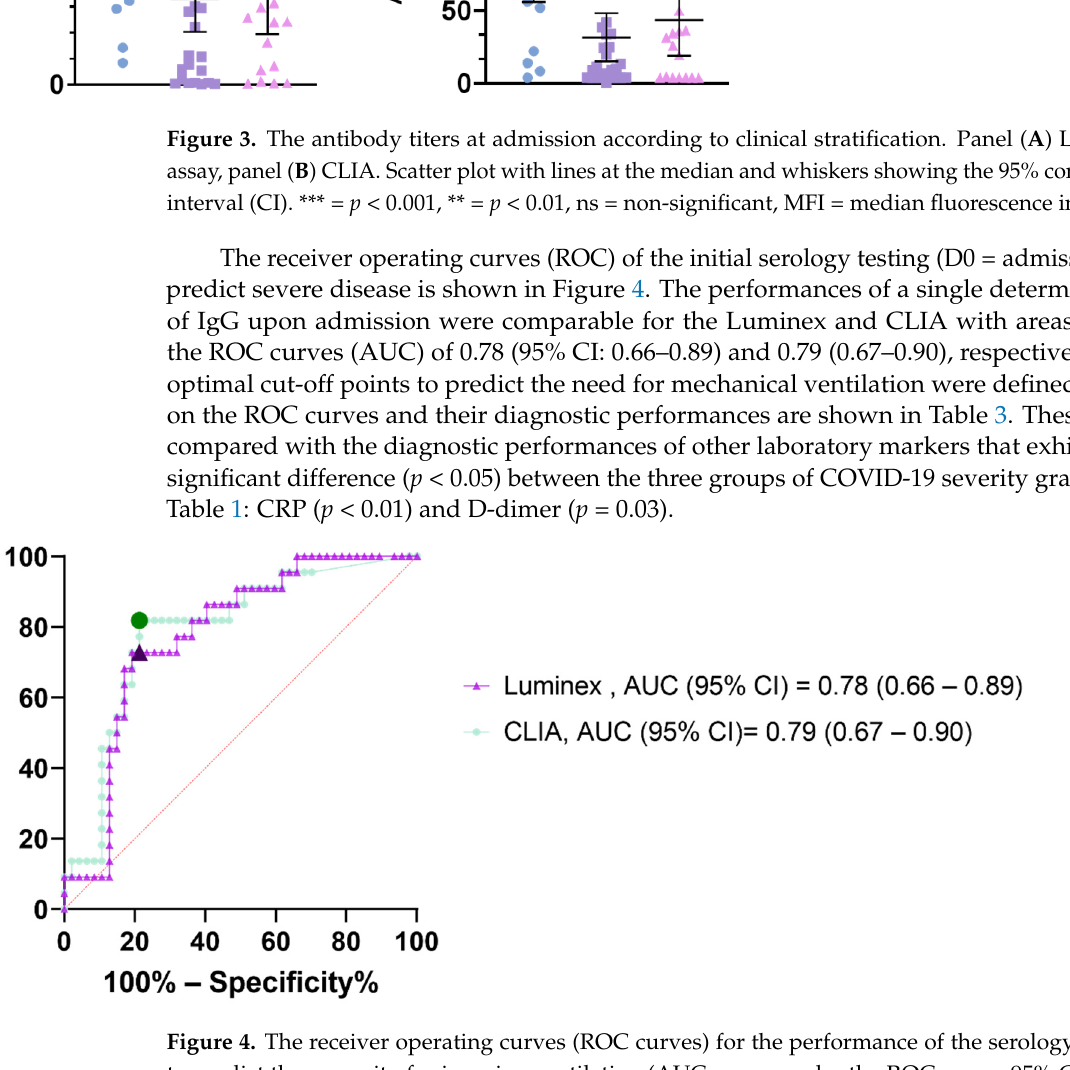
Figure 4. The receiver operating curves (ROC curves) for the performance of the serology testing to predict the necessity for invasive ventilation (AUC = area under the ROC curve, 95% CI = 95% confidence interval). The marked symbols show the performances of the optimal cut-off values. Table 3. Diagnostic performances of the selected tests to discriminate severely ill patients.